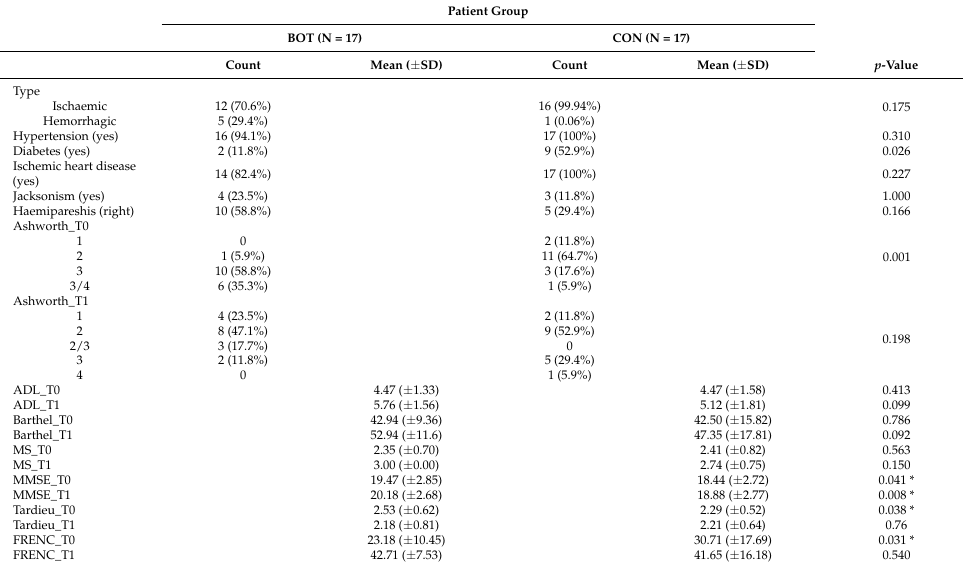
Table 2. Health status of the patients.